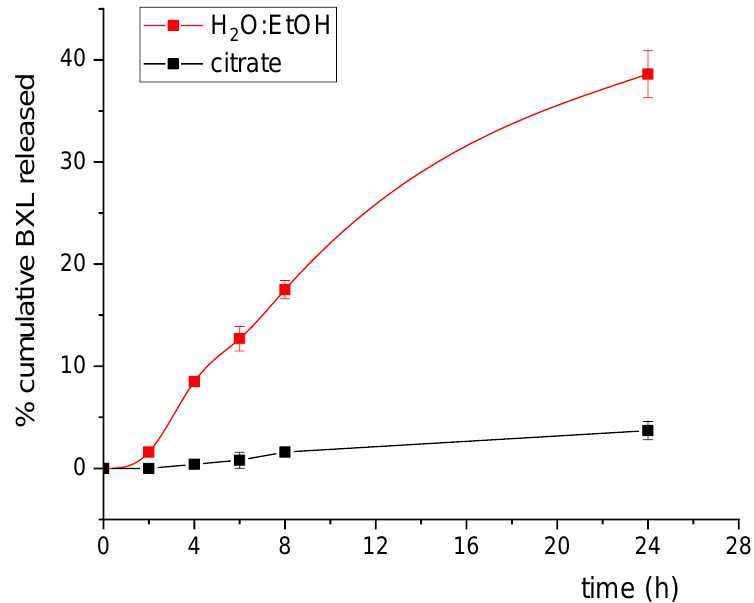
Figure 4. In vitro BXL release profile in citrate buffer (pH 5; black line) and in H 2 O:EtOH 80:20 mixture (red line). The data plotted are means ( n = 3) ± SD.